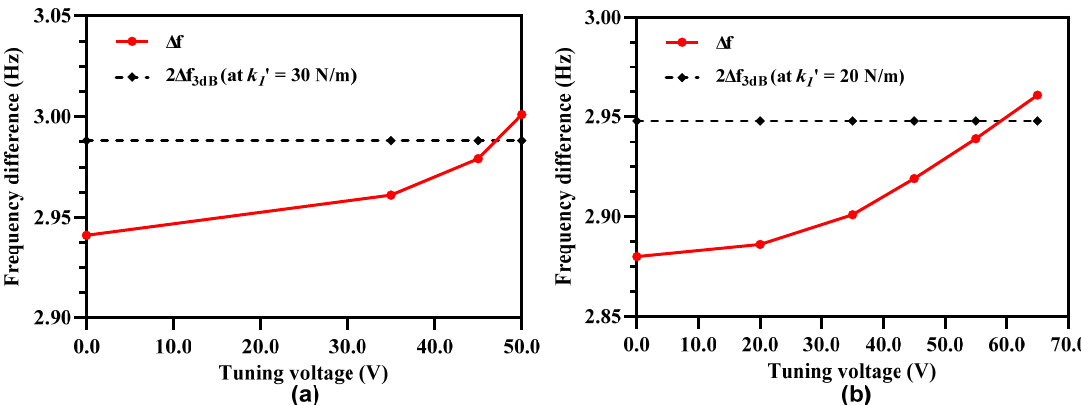
Figure 13. Effect of applying electrostatic tuning voltage to the middle resonators in 3-Dof resonator Set A and Set B on the frequency separation between two modes for ( a ) k (cid:48) = 30 N/m and ( b ) k (cid:48) = 20 N/m.